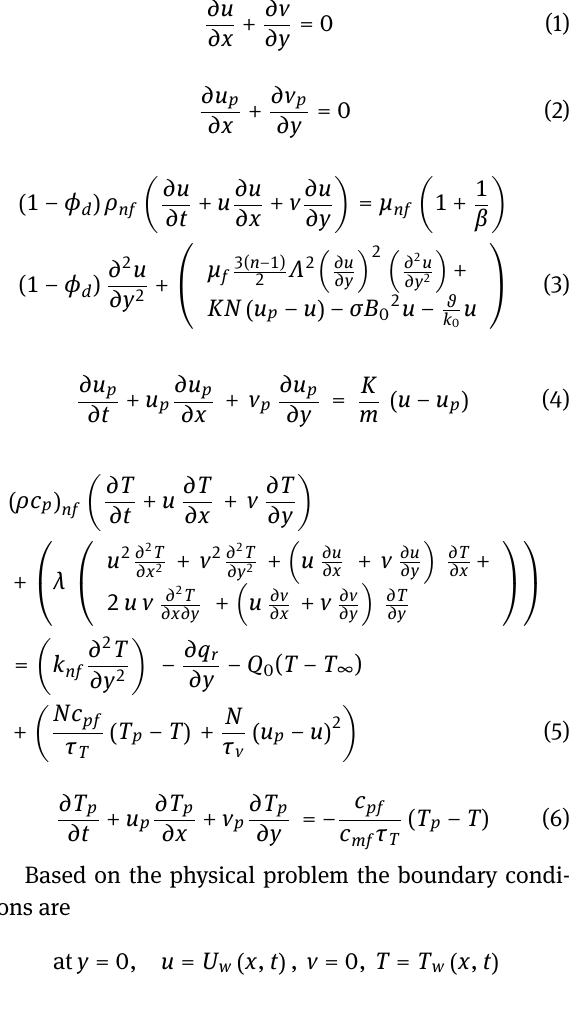
Fig. 1: Physical model representing the flow problem